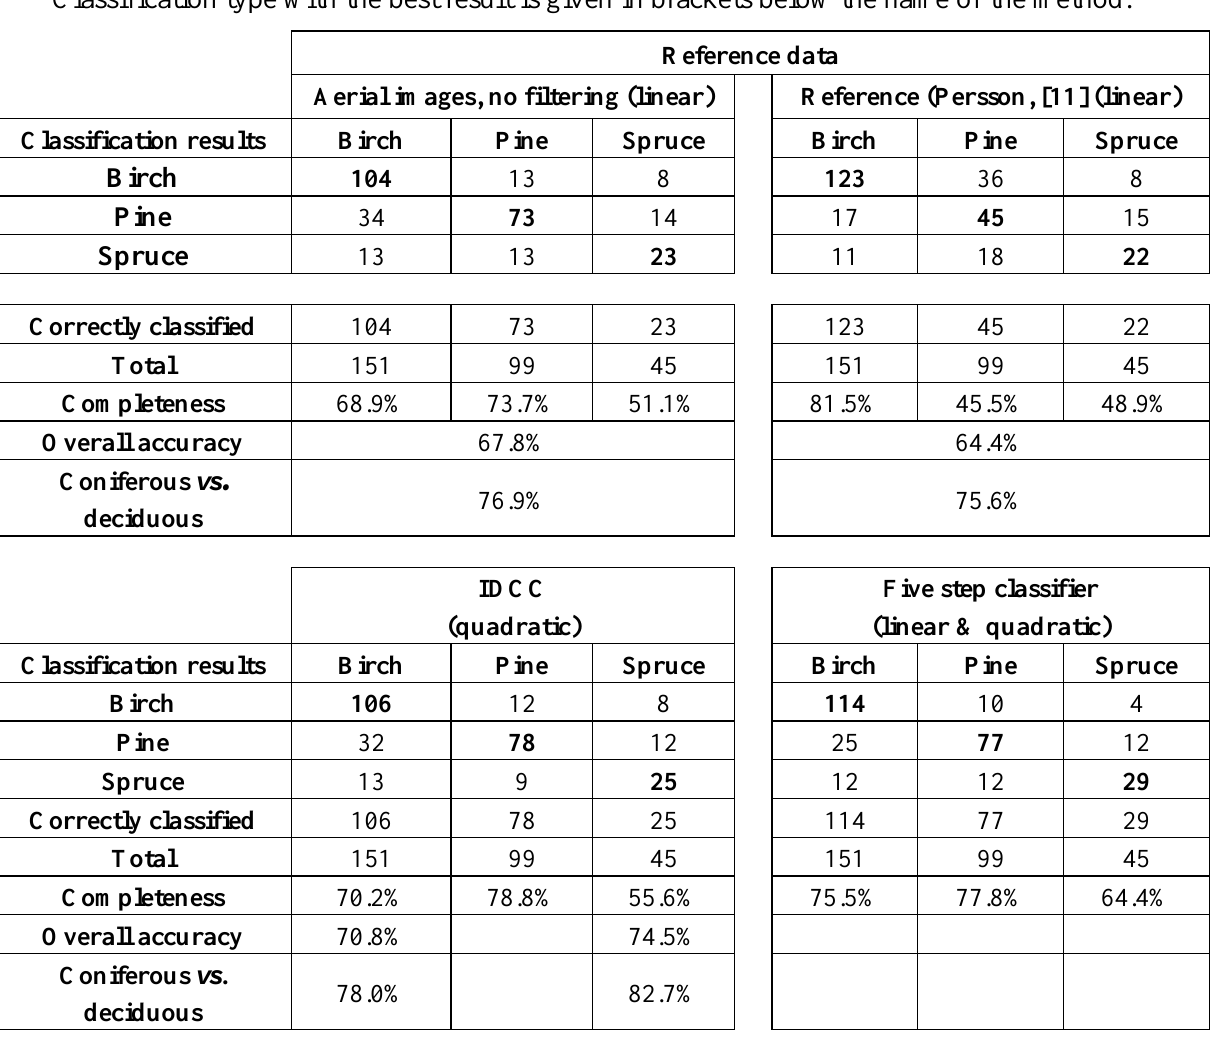
Table 1. Error matrices of the best classification results obtained with used methods. Classification type with the best result is given in brackets below the name of the